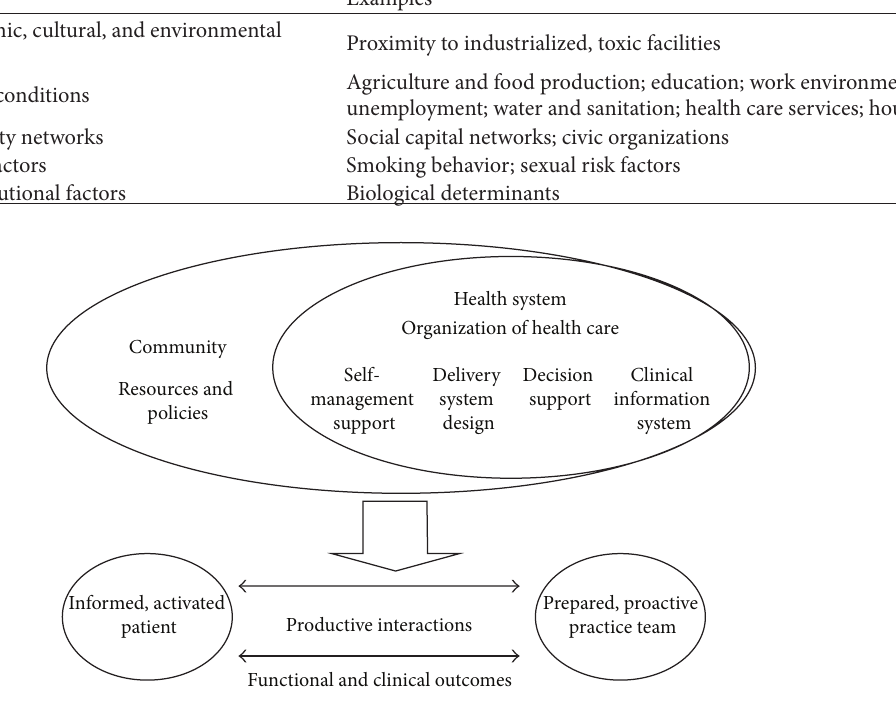
Figure 1: Chronic care